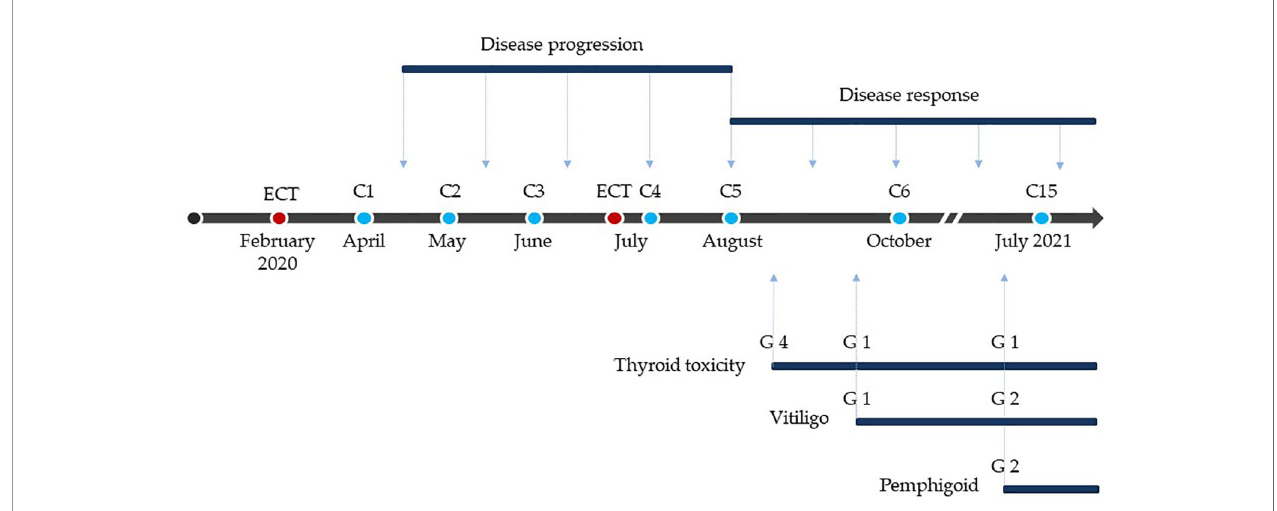
FIGURE 4 | Treatment, response and toxicity. Red dots: electrochemotherapy. Blue dots: anti-PD-1 treatments. C: cycle of anti-PD-1. G: grade of toxicity according to Common Terminology Criteria for Adverse Events (CTCAE) classi fi cation, 5.0 version.